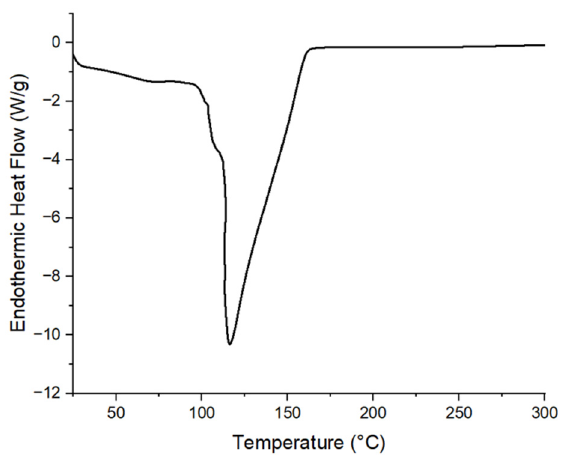
Figure 1. Differential scanning calorimetry thermogram of pineapple plant stem. Table 1. Thermal properties of pineapple plant